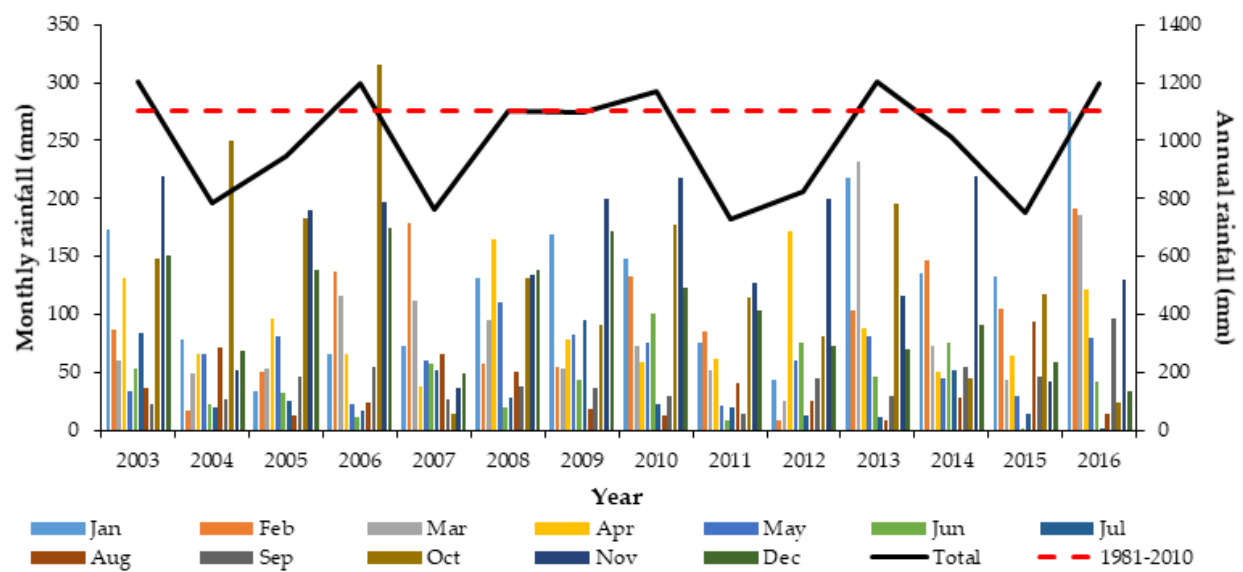
Figure 2. Monthly rainfall (mm) registered at Alvedro meteorological stations during the studied years and for the period 1981–2010 (dotted red line). Annual values are also shown (black line).